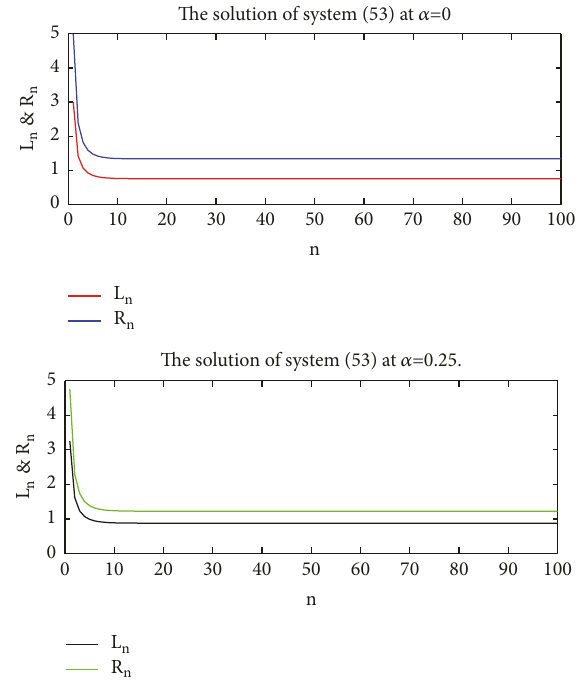
Figure 2: The solution of system (53) at 𝛼 = 0 and 𝛼 =